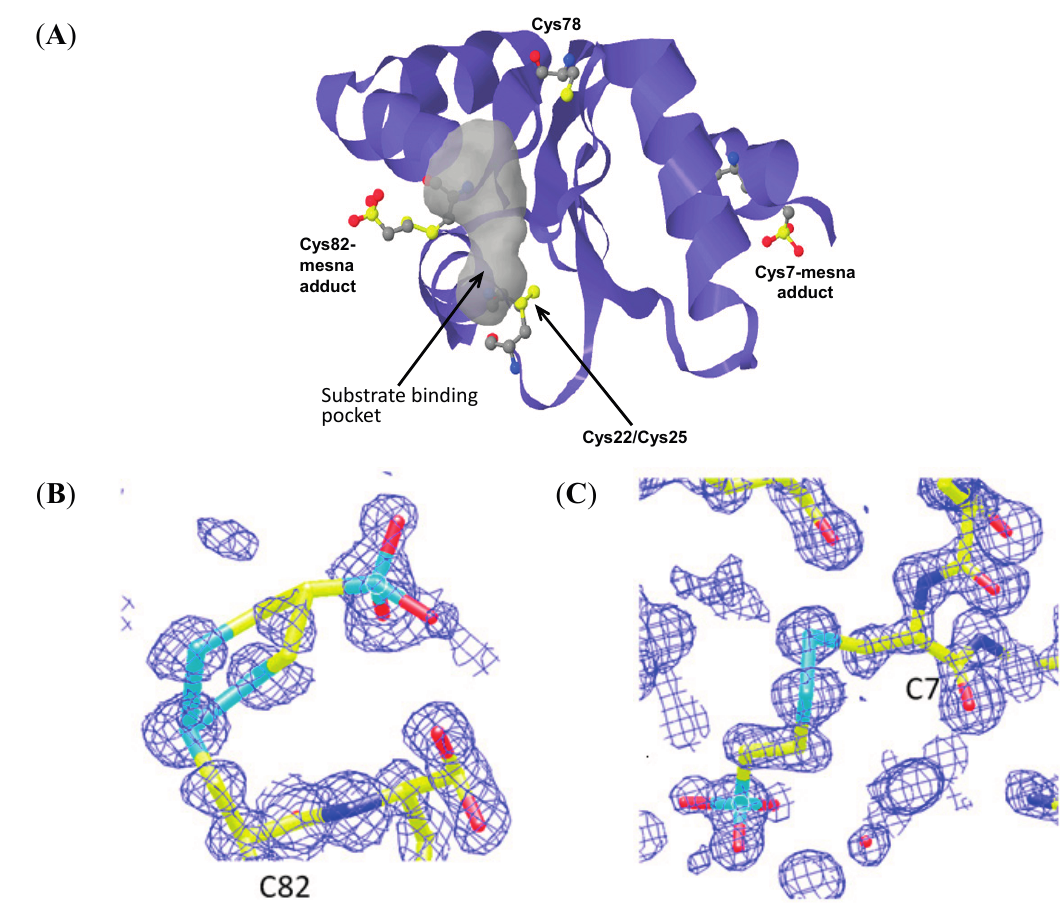
Figure 2. Structure of Grx 1-BNP7787 co-crystal. ( A ) Ribbon diagram of Grx 1 in complex with two BNP7787-derived mesna adducts at Cys 7 and Cys 82. ( B ) Atomic resolution map of BNP7787-derived mesna adduct formation on Cys 82. The adduct on Cys 82 adopts two conformations for S-C β bond of the adduct whereas the adduct on Cys 7 is in one conformation. ( C ) Atomic resolution map of BNP7787-derived mesna adduct formation on Cys 7; the BNP7787-derived mesna adduct at Cys 7, the adduct is solvent exposed and does not have interactions with the protein (C =